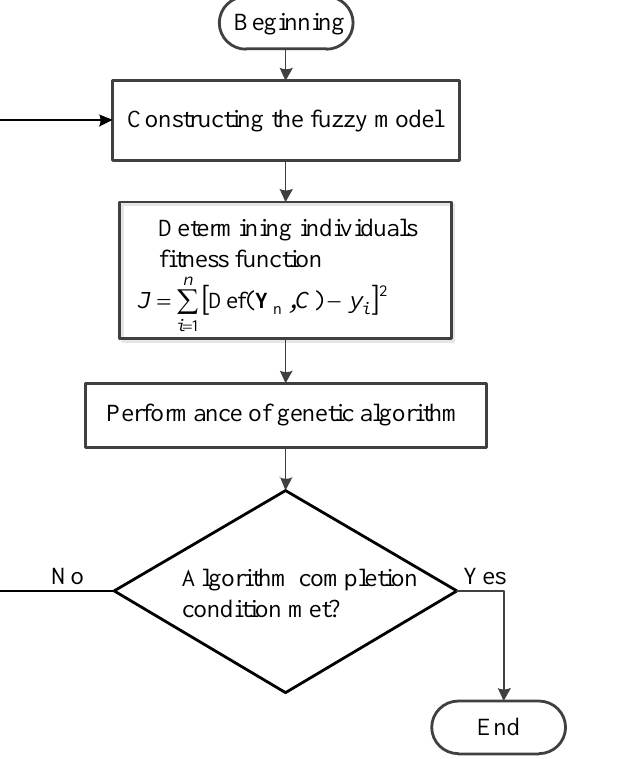
Figure 5. Block schematic diagram of the fuzzy model membership function optimization algo- rithm.